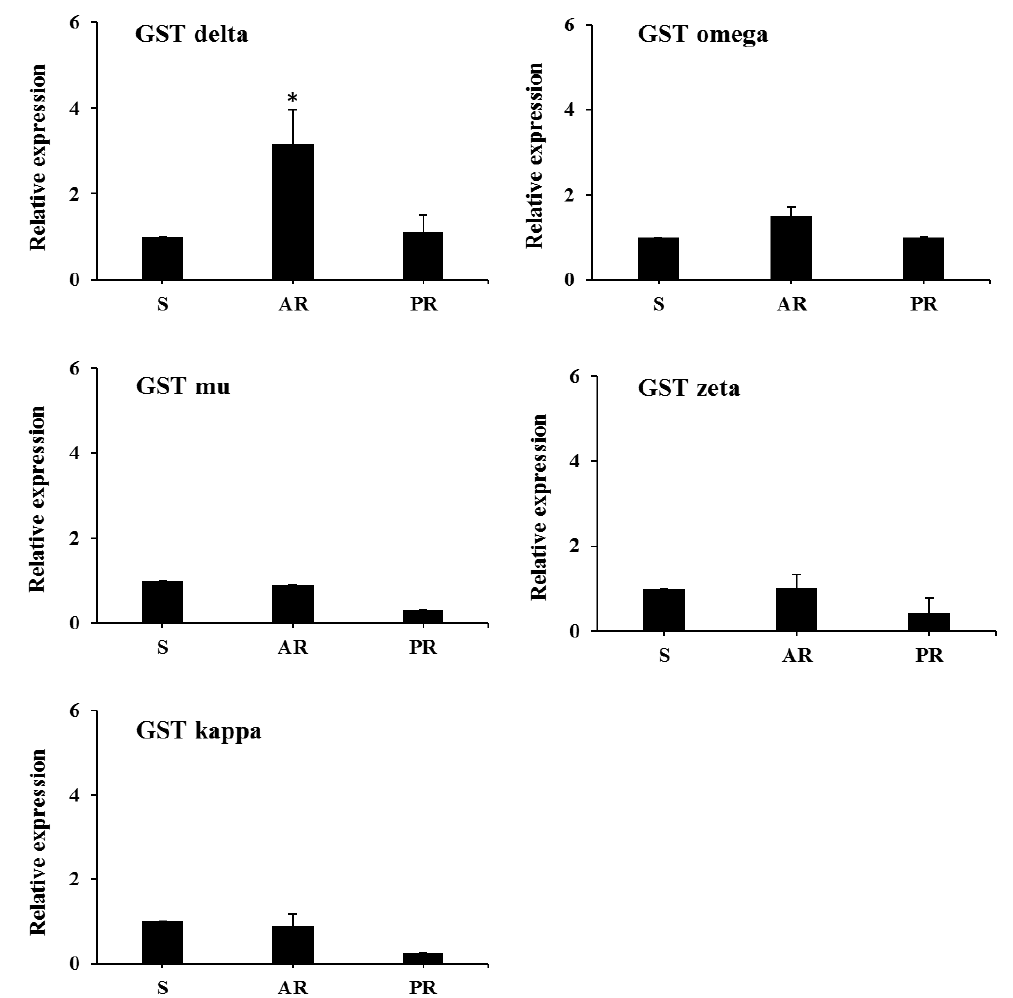
Figure 1. Relative expression levels of GST subclasses in the S, AR, and PR strains of T. urticae . The vertical bars indicate standard errors of the means ( n = 3, 4). * p < 0.05 [26].